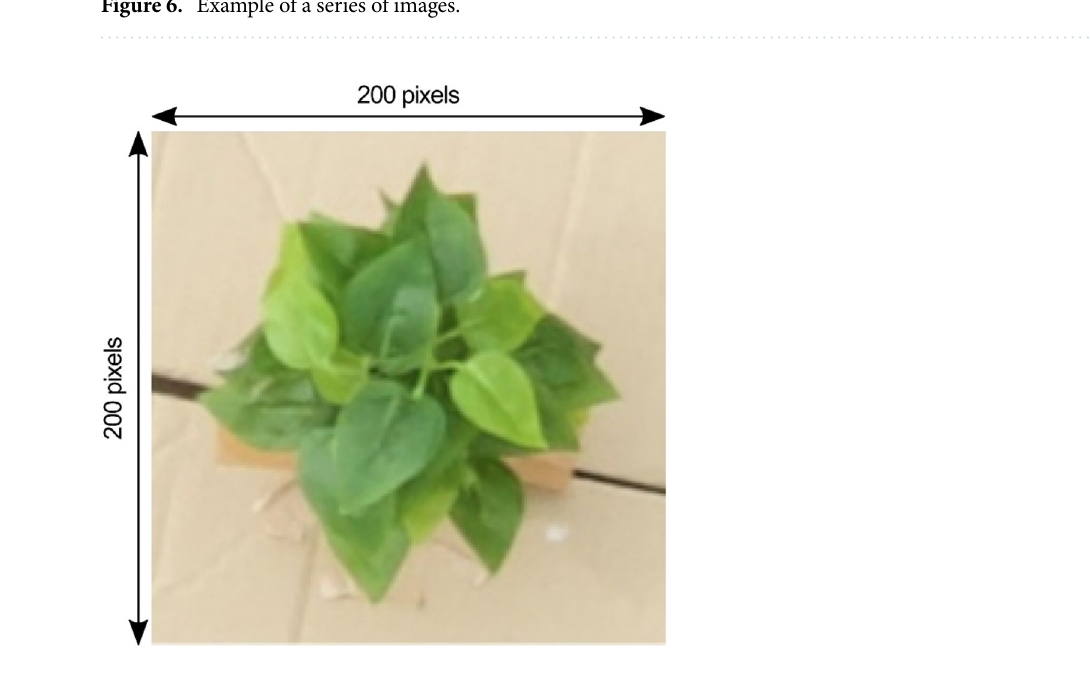
Figure 7. Enlarged view of the fake plant in the